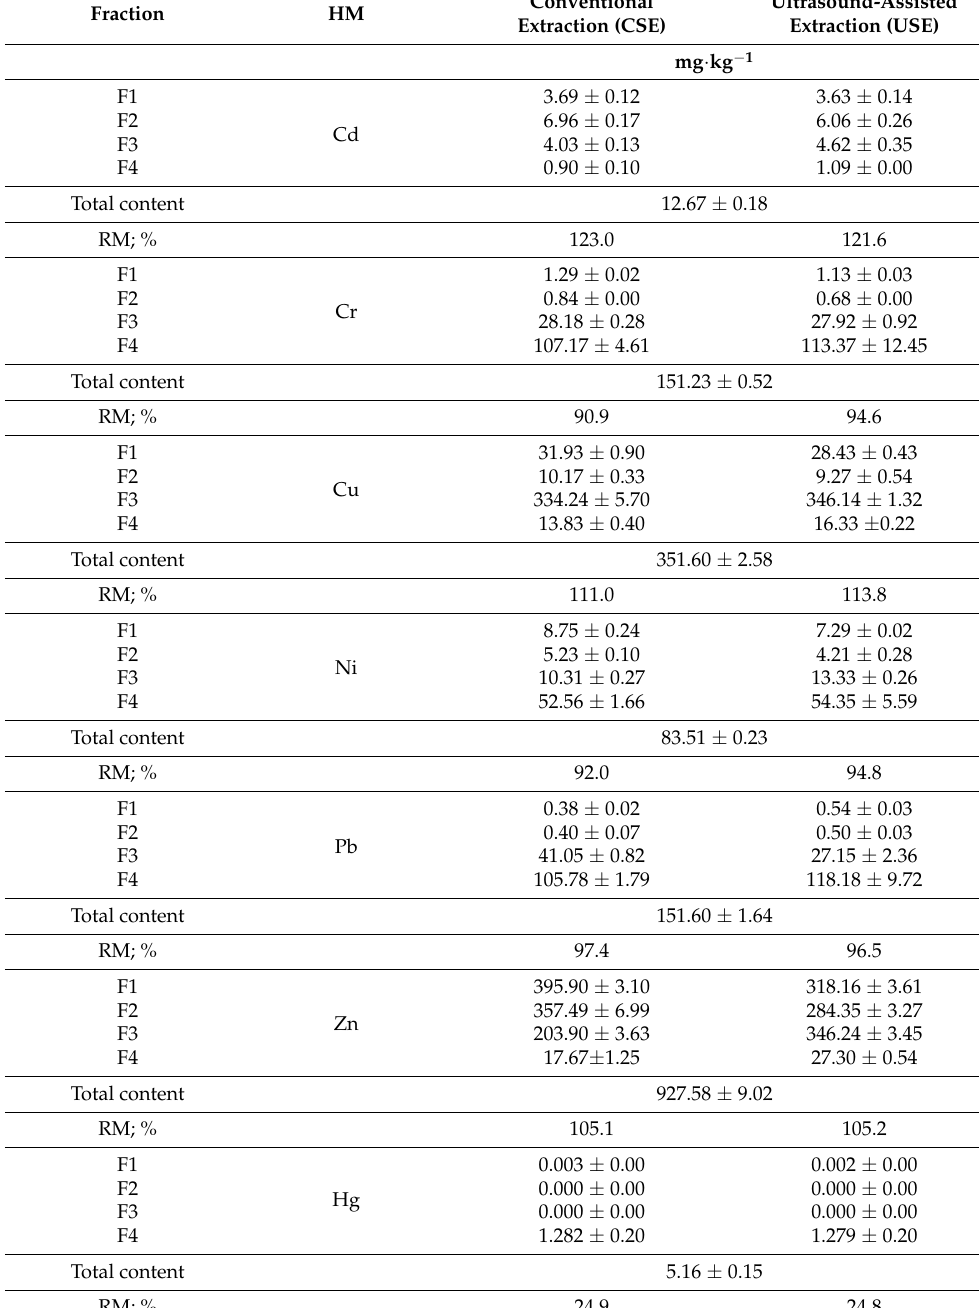
Table 4. Comparison of the results obtained by the conventional and ultrasound-assisted sequential extraction methods based on the heavy metal content in ERM-CC144